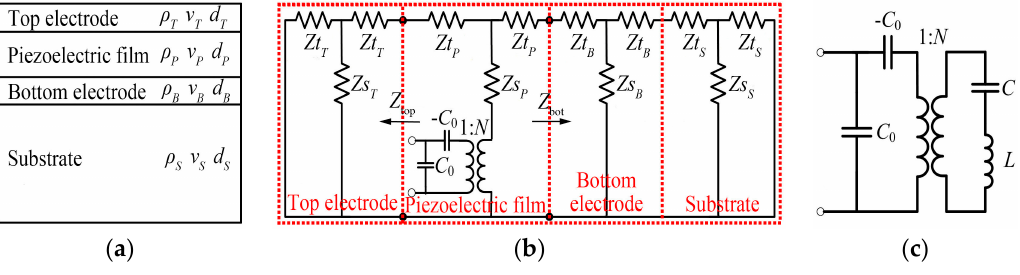
Figure 1. ( a ) The cross-section schematic of HBAR; ( b ) The one-dimensional Mason equivalent circuit model; ( c ) The lumped parameter equivalent circuit near the resonance frequency.